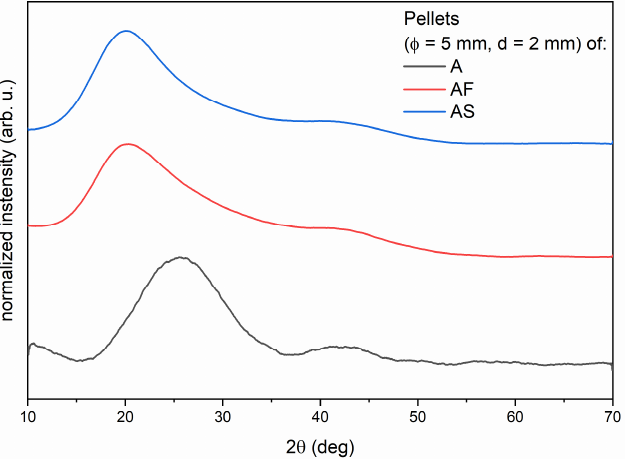
Figure 2. XRD diagrams of ormocer materials. The study was performed for one randomly selected